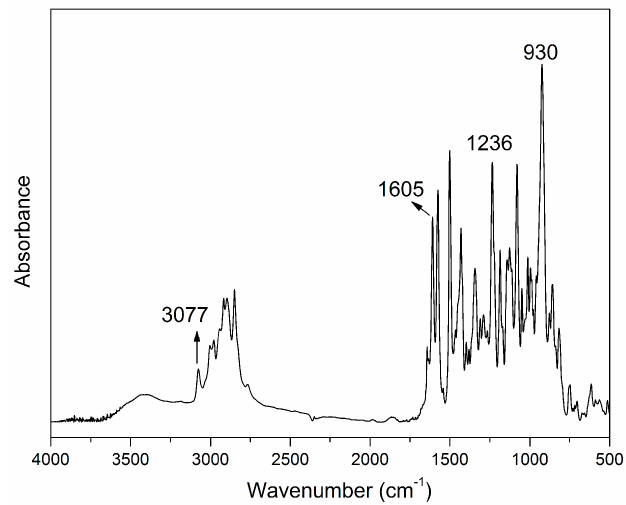
Figure 3. FT-IR spectra of RES-al.